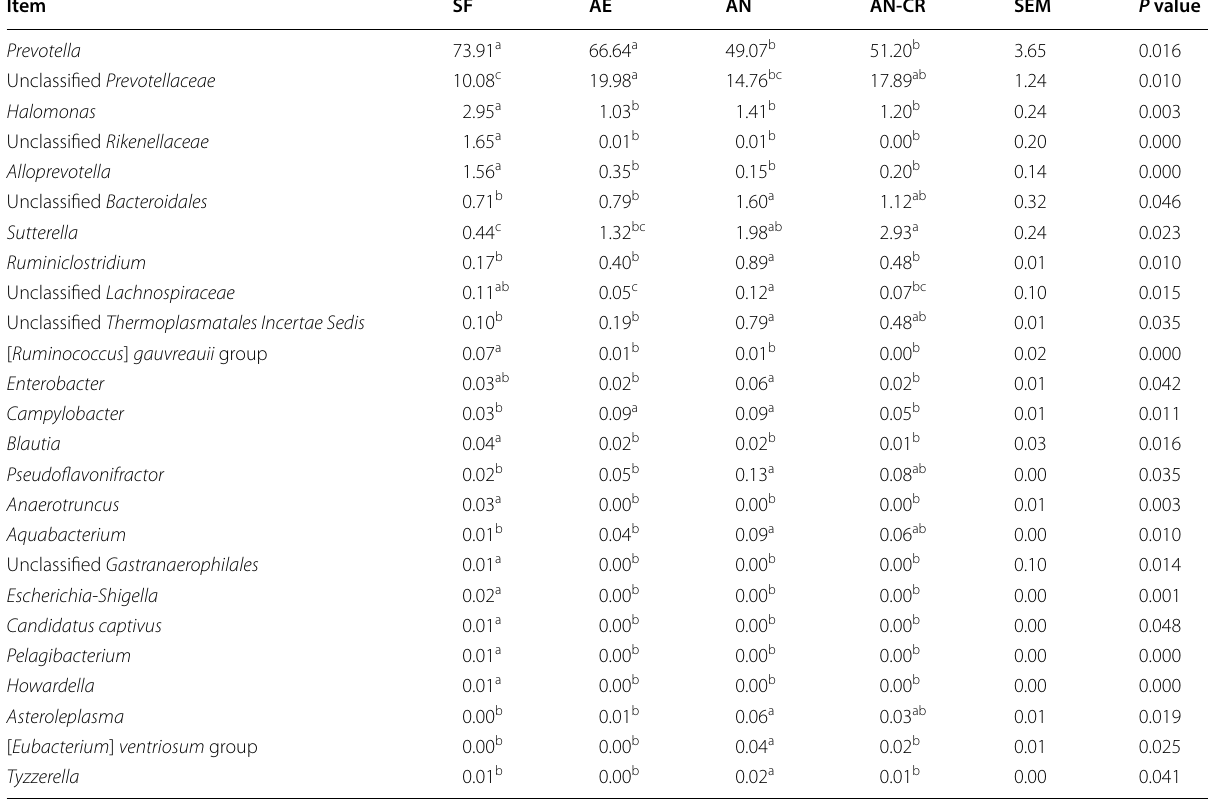
Data are expressed as mean and standard error of means (SEM), n another SF sows’ fecal group, AE aerobic group, AN anaerobic group, AN-CR anaerobic-cryopreserved